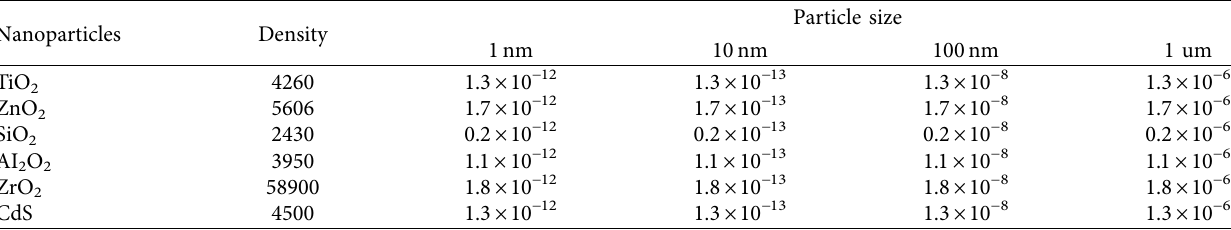
Table 2: Statistics of settling velocity of nanoparticles in water.